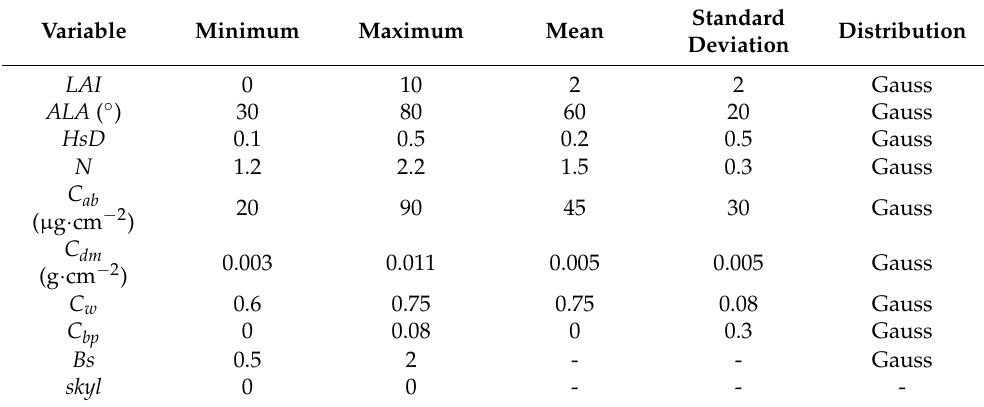
Table 2. Distribution of PROSAIL input variables to generate the Gaussian distribution LUT. ALA = Average Leaf Angle inclination; HsD = Hot-spot parameter; N = leaf structure parameter; C ab = chlorophyll content; C dm = dry matter content; C w = leaf water content; C bp = brown pigment can be found in [4].